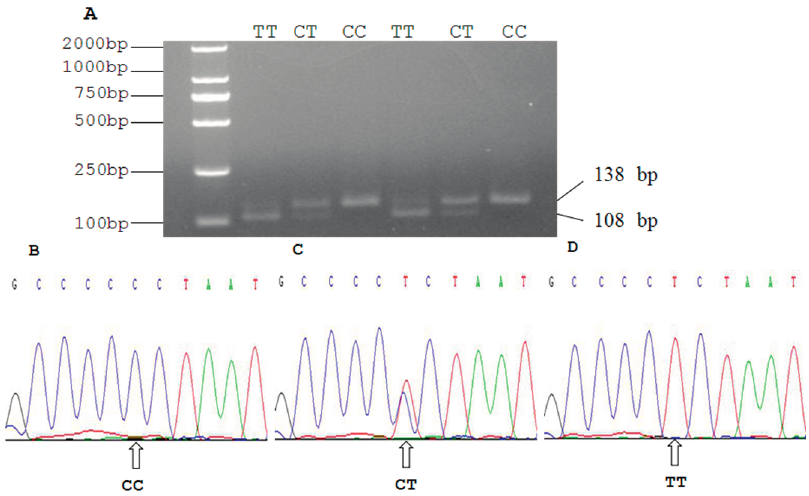
Figure 4. ( A ) PCR-RFLP detection results of SIRT2 gene PCR product (19,518 bp locus); ( B – D ) The sequencing maps of the novel SNP of SIRT2 gene (19,518 bp locus).